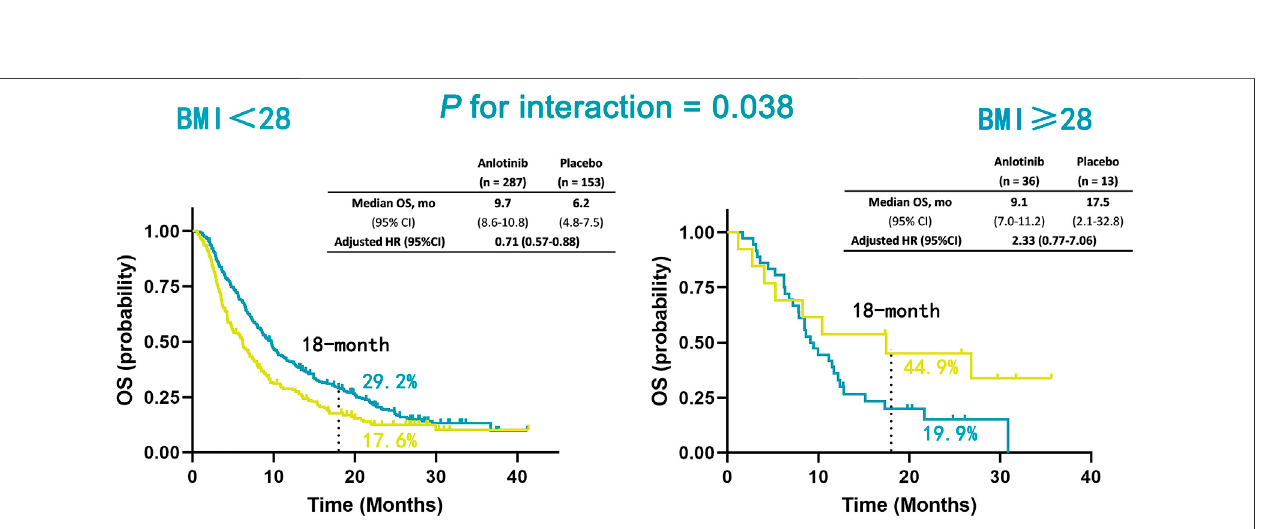
FIGURE3| Kaplan-MeierestimatesofOSinnon-obesity(BMI < 28 kg/m 2 )andobesity(BMI ≥ 28 kg/m 2 )patientsinanlotinibandplacebotreatmentgroups.Overall survival (OS); body mass index (BMI).